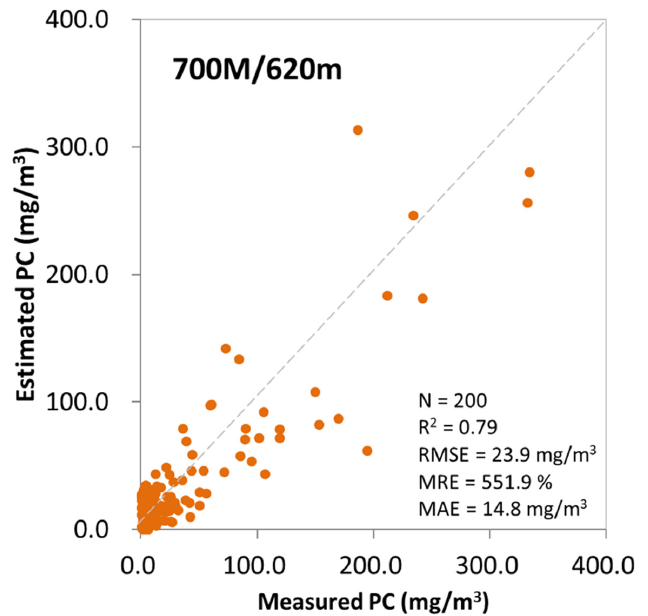
Figure 8. Results obtained by regression of only the band-ratio part of BRPD for evaluating the effect of including peak shift on prediction accuracy. The same 200 calibration datasets used in Figure 4 were used here.